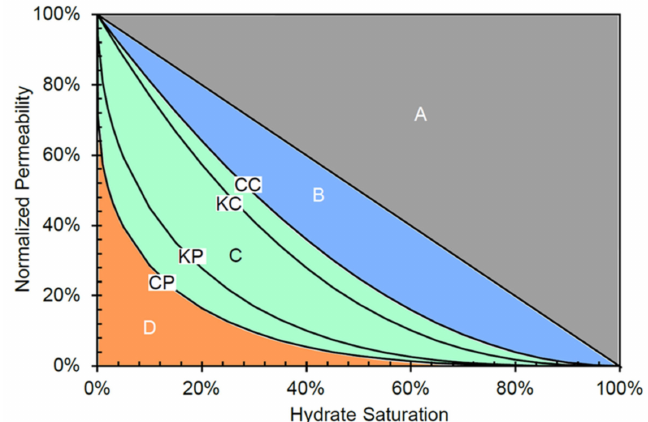
Figure 45. Several zones in the hydrate saturation-normalized permeability space reprinted from [39] with permission from